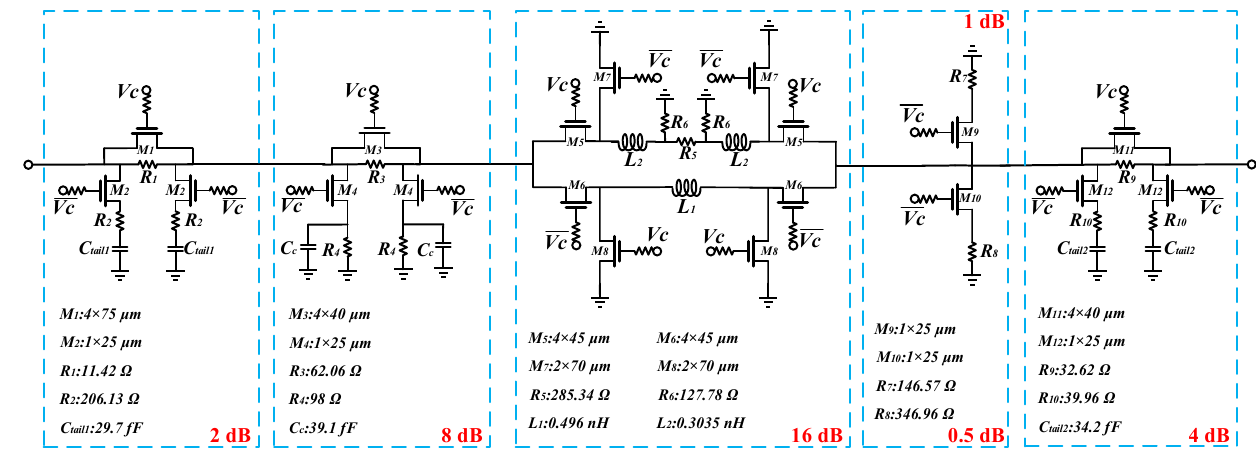
Figure 13. The simplified schematic of the proposed 6-bit DSA.